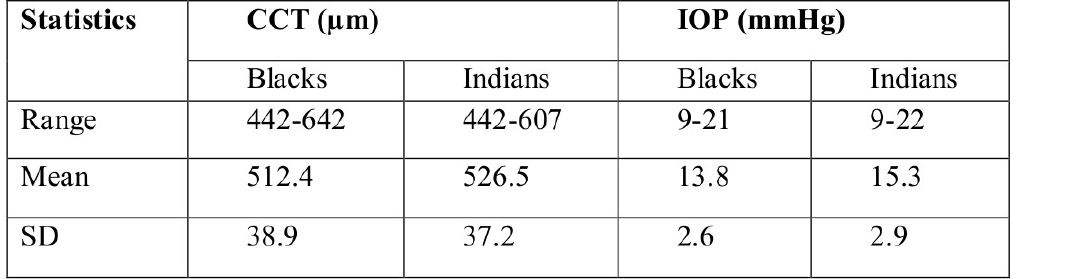
Table 2: Showing the range, mean and SD for CCT and IOP in relation to gender of the total population; Males (M): N = 100 and Females (F): N =